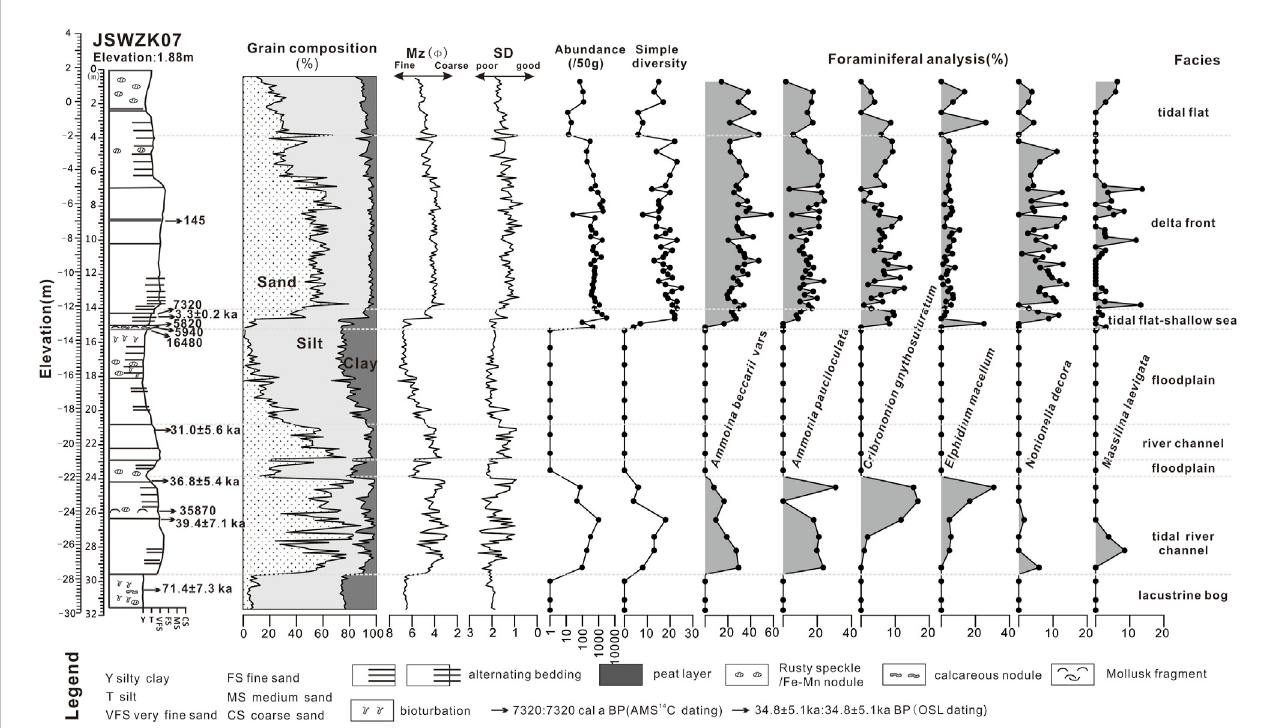
FIGURE 7 Comprehensive stratigraphic log of the core JSWZK07, showing lithology, grain size, and foraminiferal content. The borehole can be divided into six sedimentary facies from the Late Pleistocene lacustrine bog, tidal river channel, river channel, and fl oodplain to the Holocene tidal fl at – shallow sea, delta front, and tidal fl at. It is to be noted that the foramiferal data (i.e., abundance) changed abruptly at the depths of 24 m and 15.2 m, indicating the end of MIS 3 marine transgression and the initiation of Holocene aggression in the core JSWZK07, relatively. For more detailed foraminiferal data, see Supplementary Table S3 in the